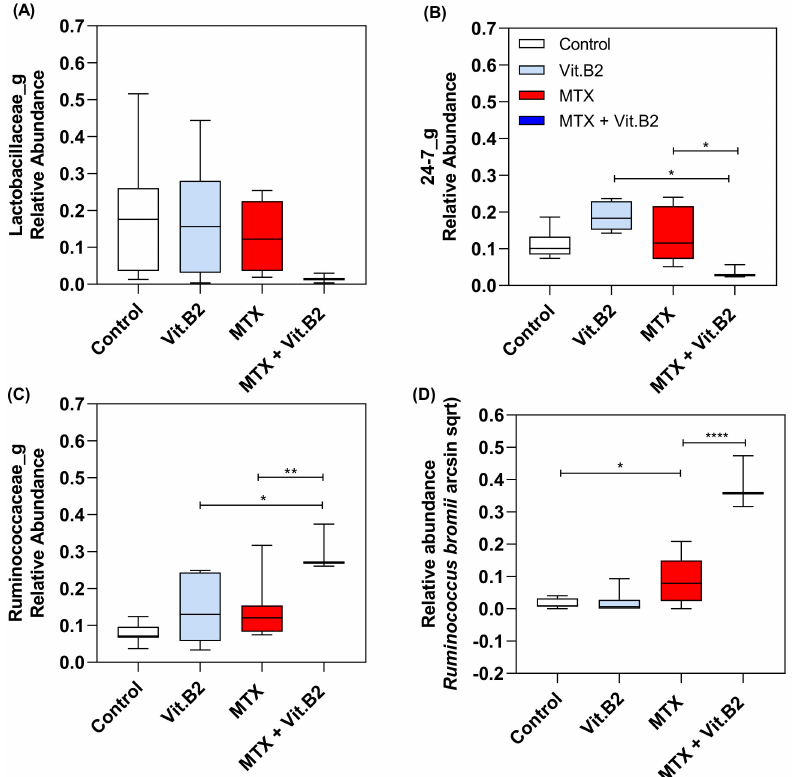
Figure 8. Relative abundance between healthy controls and MTX-treated and MTX and Vitamin B2-treated rats at day 4 after MTX insult. Relative abundance of Lactobaciliaceae ( A ), Muribaculaceae S24-7 ( B ), Ruminoccoceae ( C ) and Ruminococcus bromii ( D ). Relative abundance of Lactobacillus johnsonii and Escherichia coli were calculated as arcsin sqrt. * ( p < 0.05), **( p < 0.01) and **** ( p < 0.0001) represent the significant changes in the relative abundance between the different